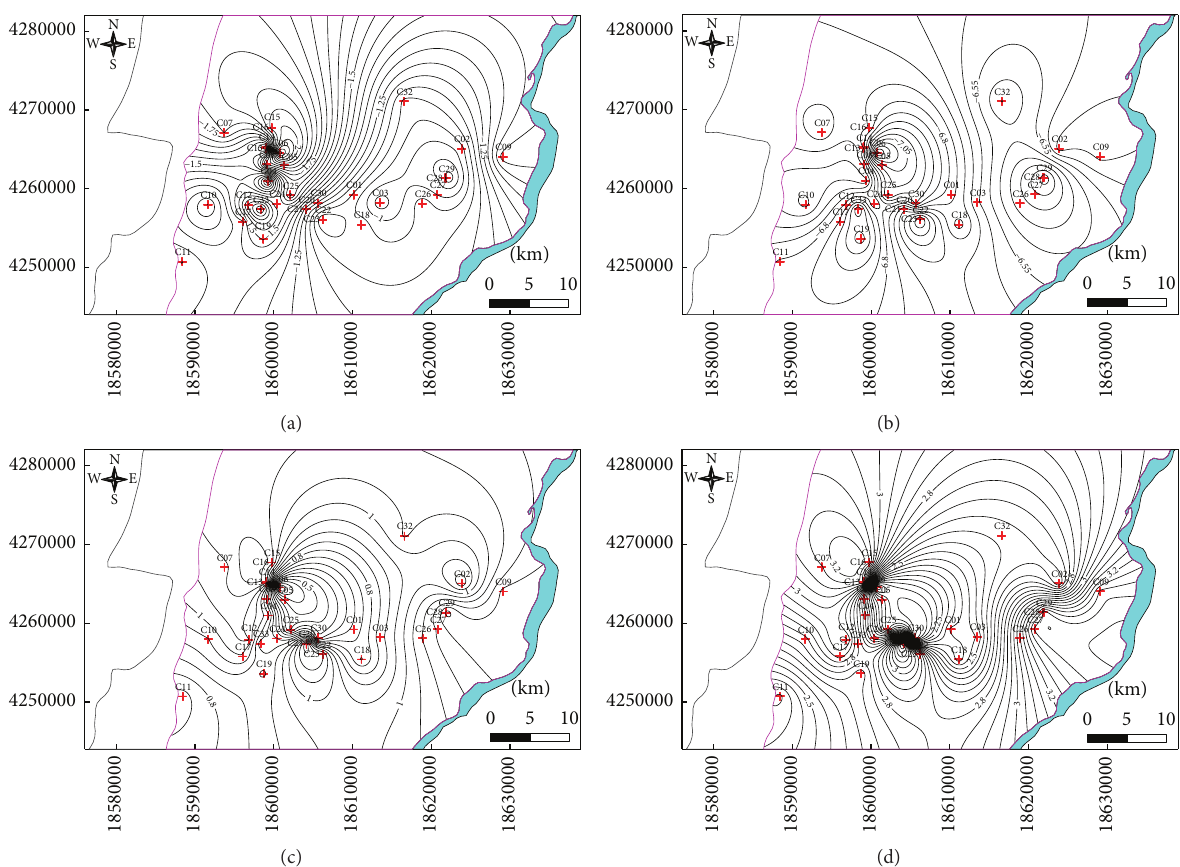
Figure 8: Saturation indices of minerals of confined water: (a) gypsum, (b) halite, (c) calcite, and (d)